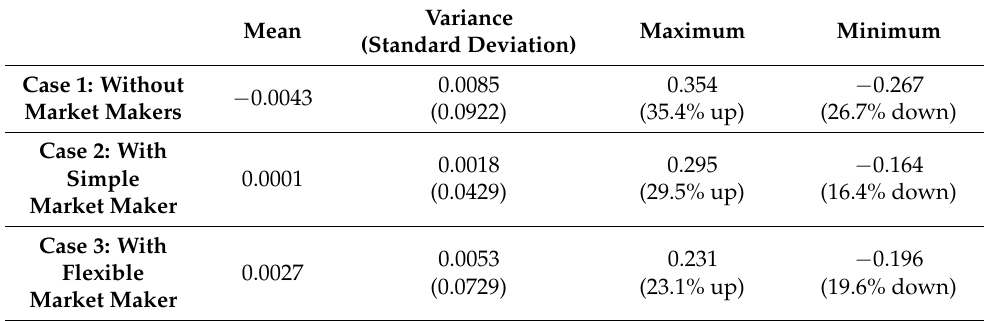
Table 12. Comparison of change rates of executed prices for the three cases.